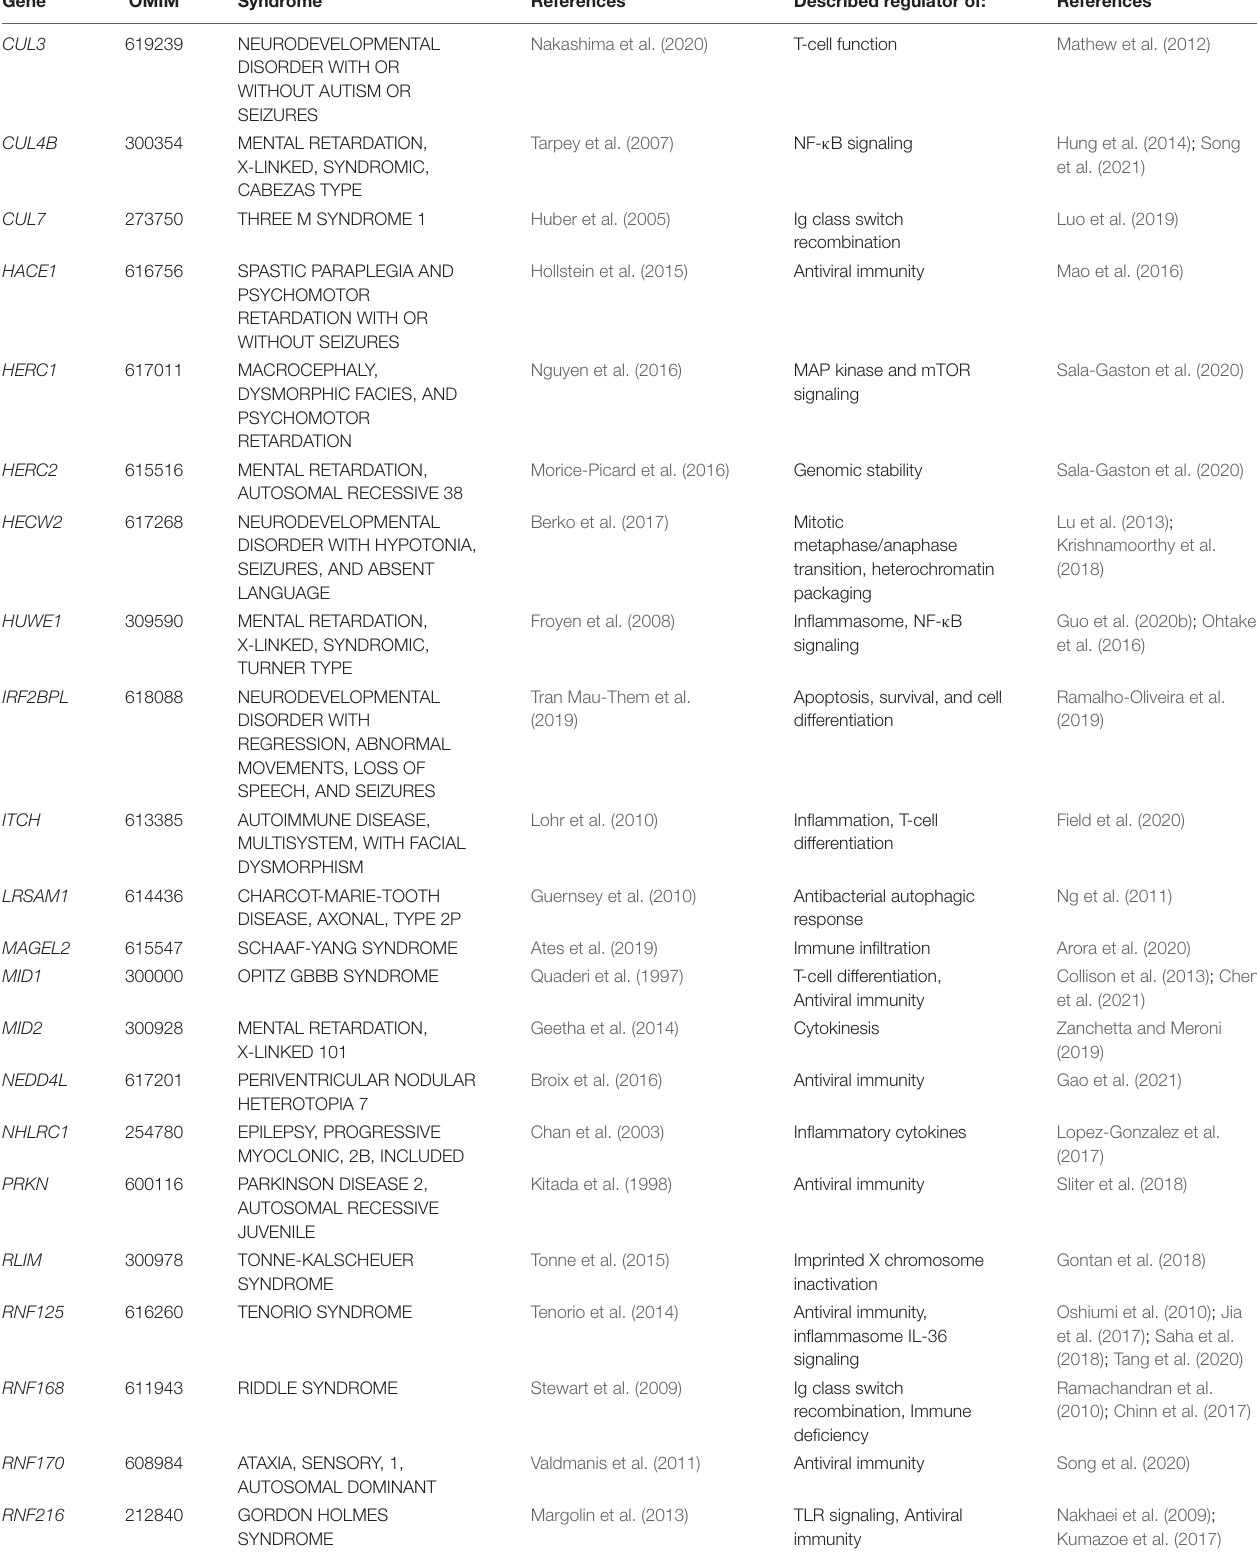
TABLE 1 | NDD-causing genes encoding E3 ubiquitin ligases and associated syndromes. Gene